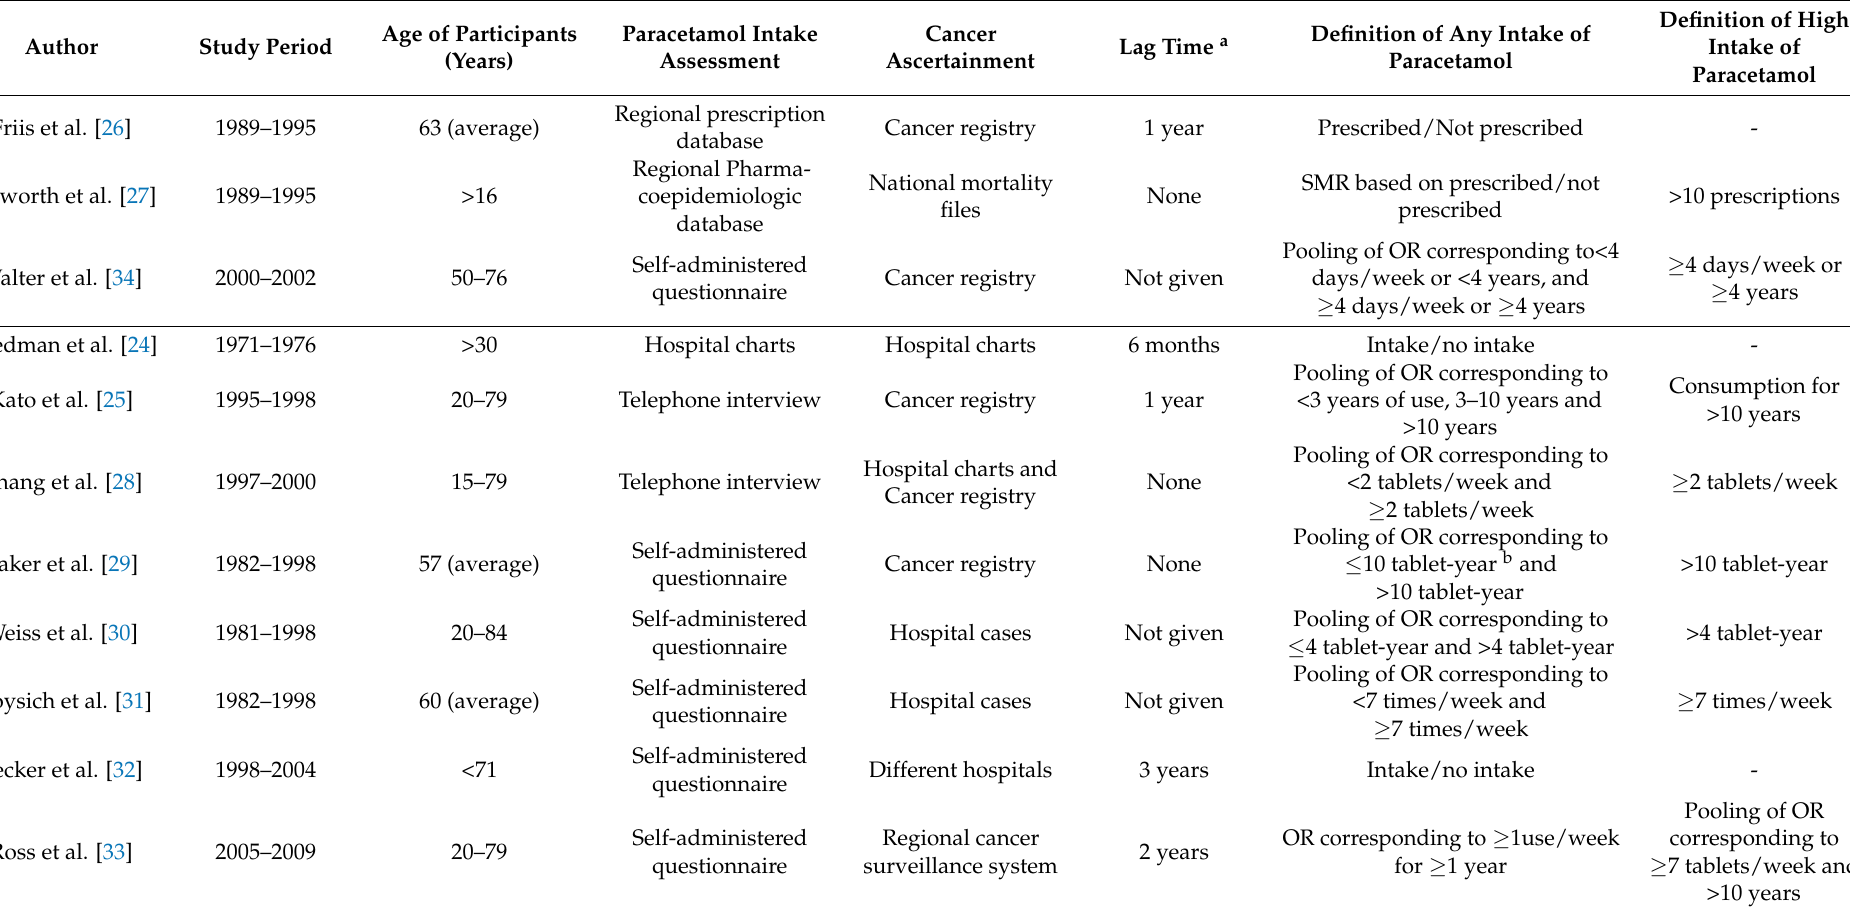
Table 1. Characteristics of studies evaluating paracetamol intake and risk of hematologic